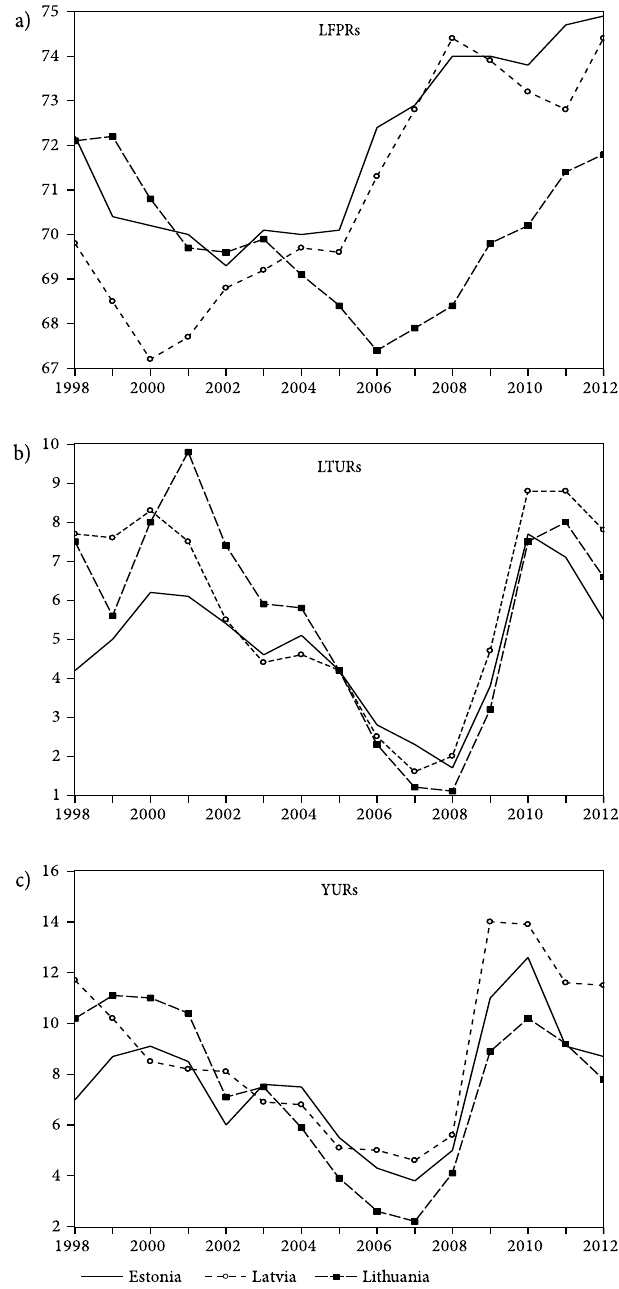
Fig. 4. (a) Labour force participation rates (LRPRs), (b) Long-term unemployment rates (LTURs) and (c) Youth unemployment rates (YURs) Source : Eurostat